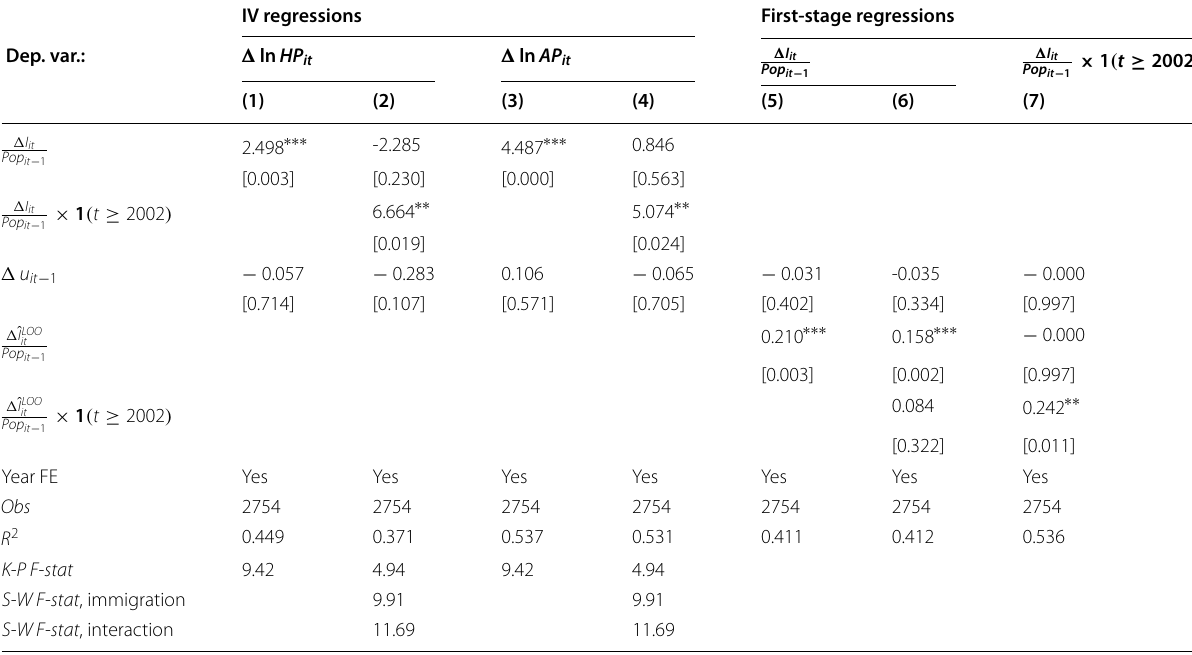
Table 15 Houseing prices and immigration—MS-regions from 1990-2016: LOO instrument. Source: Own calculations based on data from Wüest Partner and Federal Statistical